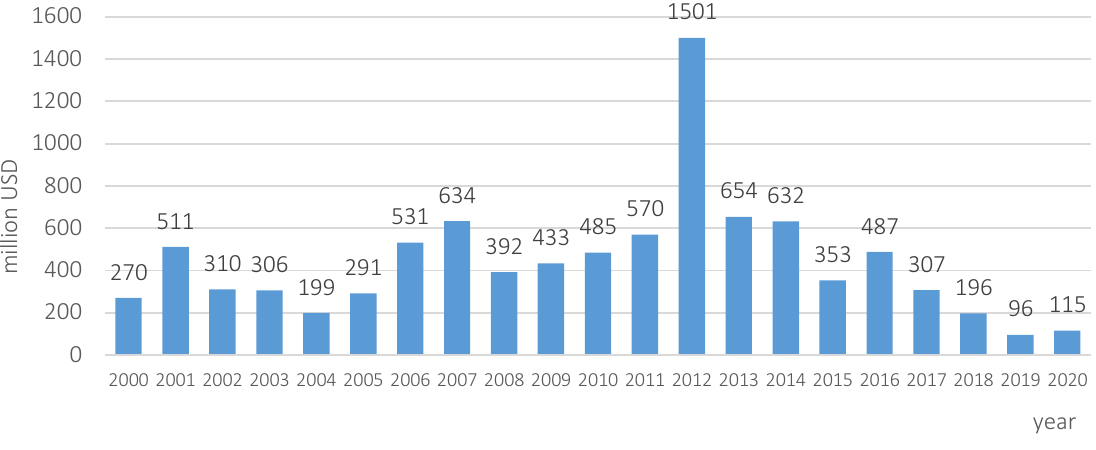
Figure 6. Ukraine’s arms exports in 2000–2020, million